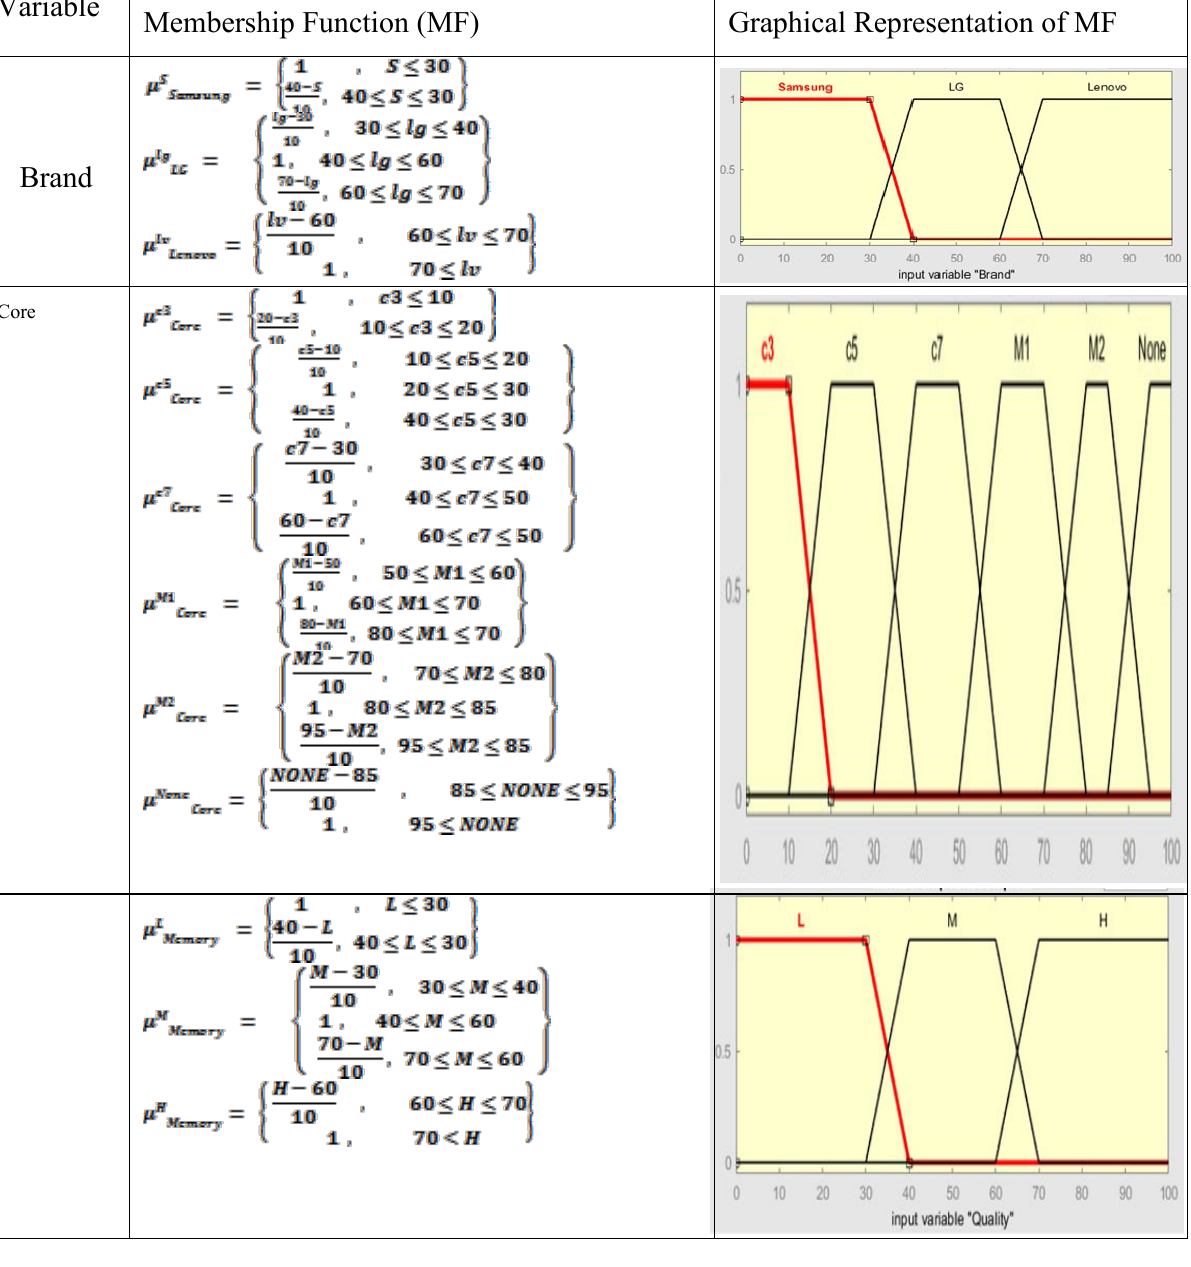
Table 1. Input and Output Variables Membership Functions used in Proposed HKCFIS